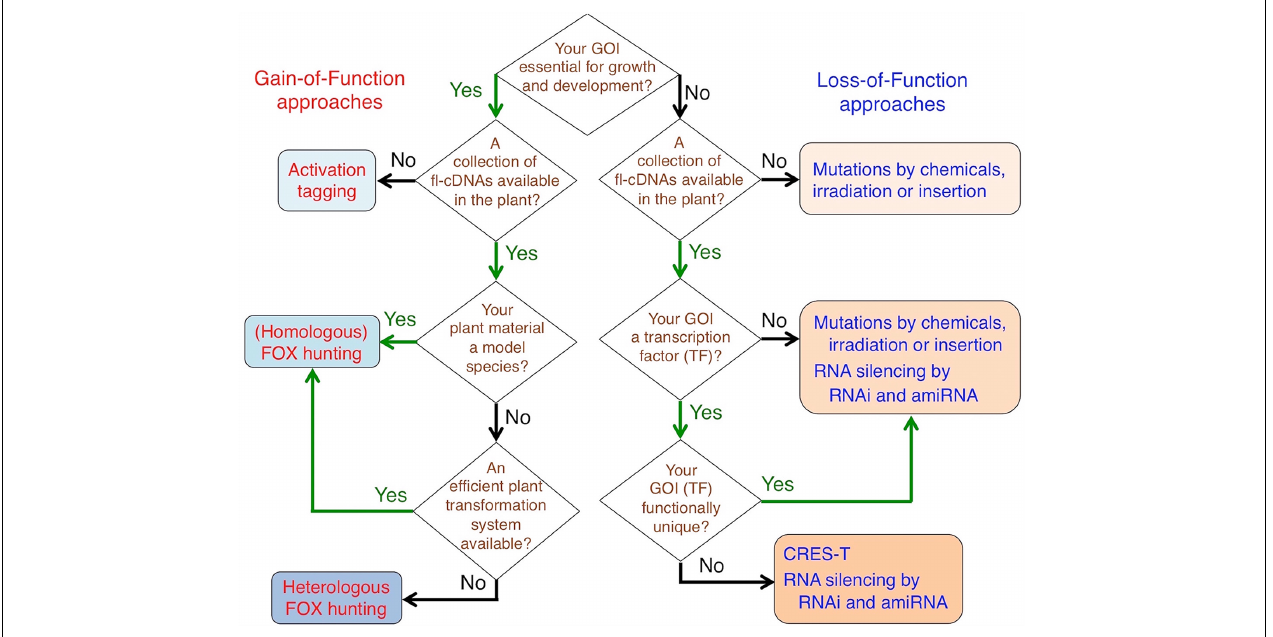
FIGURE 1 | Choosing appropriate resources to isolate your gene(s) of interest by forward and/or reverse genetic approaches. GOI, Gene(s) of